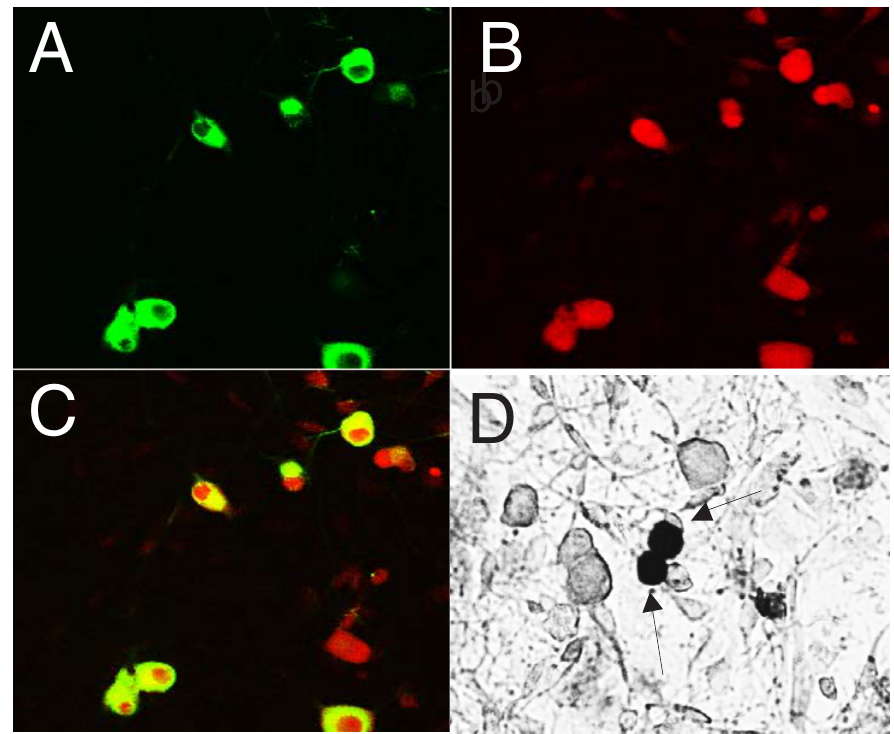
Figure 6. Biotinylated NMB-1 binds to peripherin-positive DRG neurons. Primary cultures of DRG neurons were stained with biotinylated NMB-1 and streptavidin linked to Cy3. ( A,C ) or alkaline phosphatase ( D ). Counter-staining with a monoclonal antibody to peripherin ( B ) shows in merged figure ( C ) that nearly all NMB-1 binding neurons express peripherin. Large diameter sensory neurons ( E ) were negative for NMB-1 binding. No signal was visible when NMB-1 was omitted from the staining procedure.